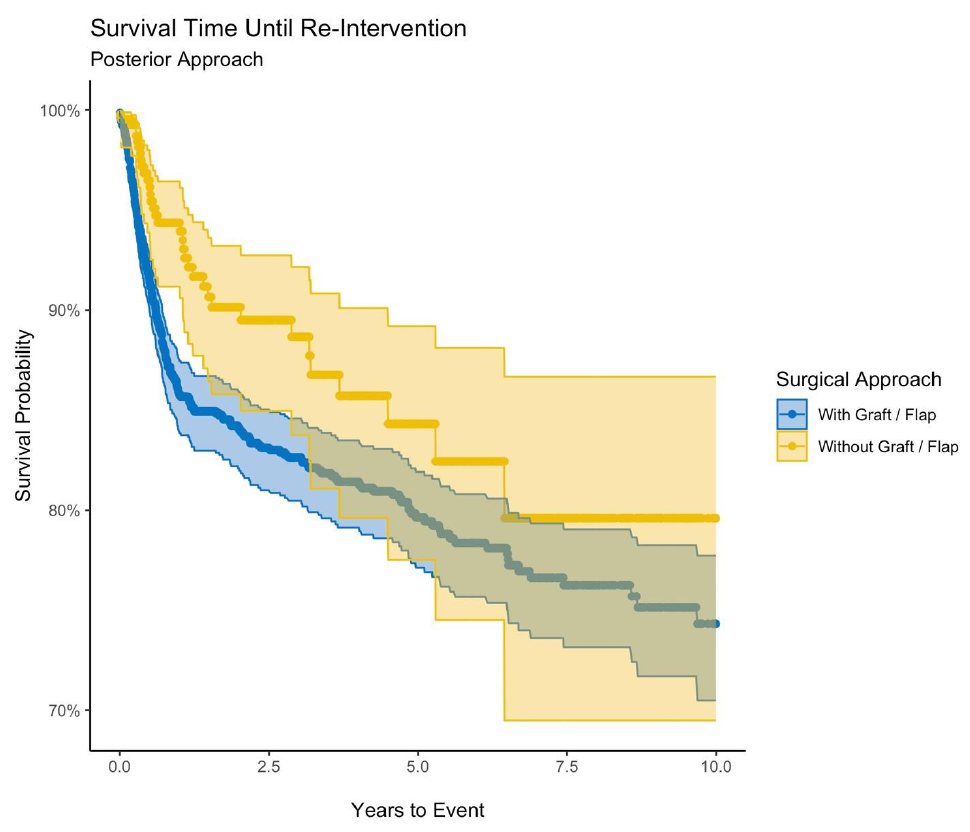
Figure 2. Survival time until reintervention (posterior approach).